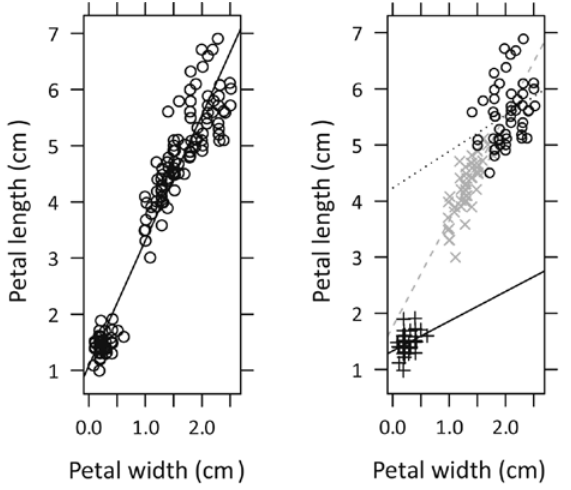
Figure 3 - Association between petal length and width for three Iris species: I. setosa (+), I. versicolor (×) and I. virginica (○). In the left panel, groups (Iris species) are ignored and the correlation coefficient (0.96) is determined for the pooled data. In the right panel, groups are correctly taken into account and correlation coefficient is determined for each species separately, giving 0.33 for I. setosa , 0.79 for I. versicolor and 0.32 for I.